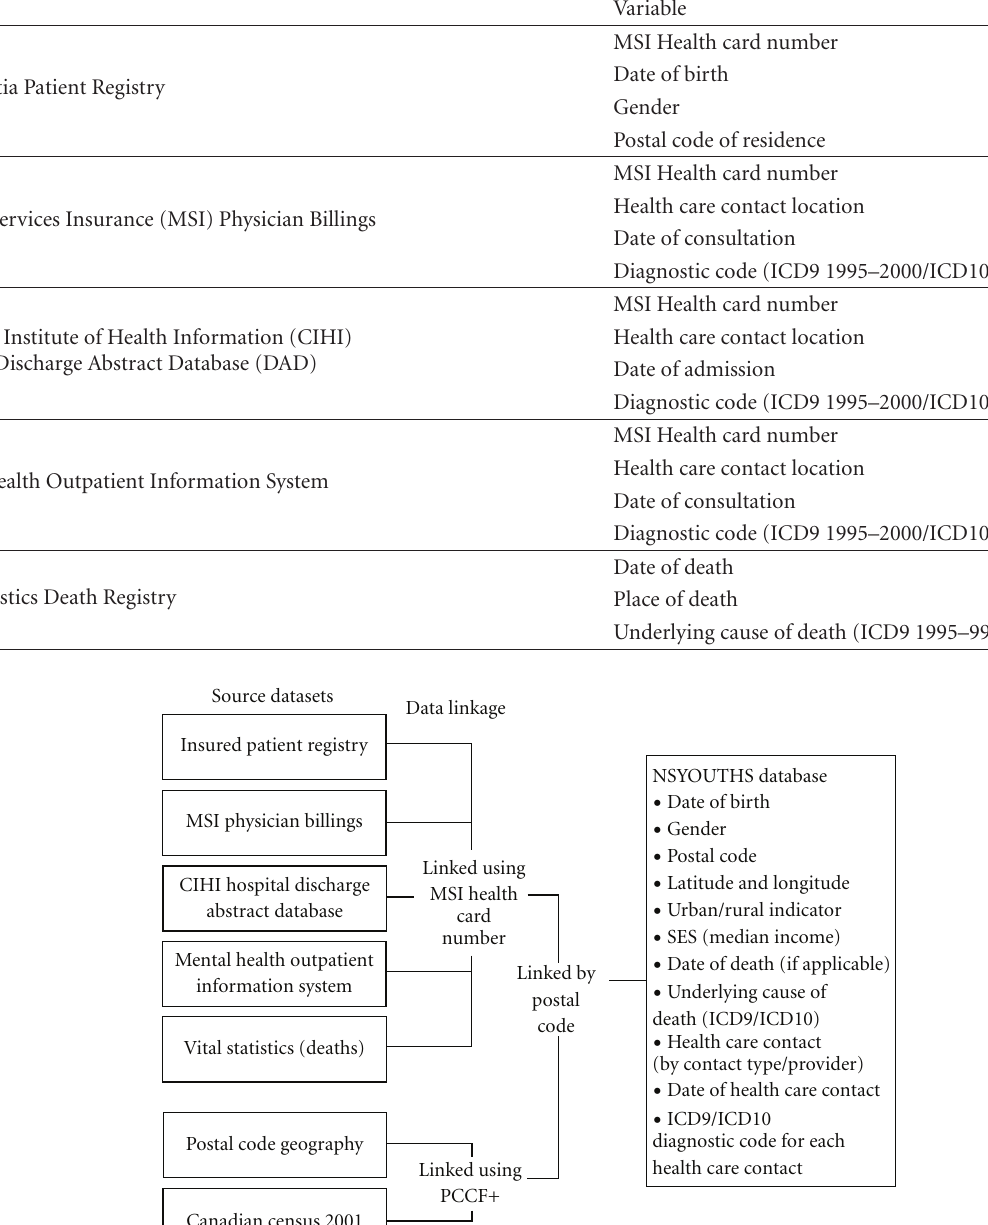
Table 1: Variables and health data sources.